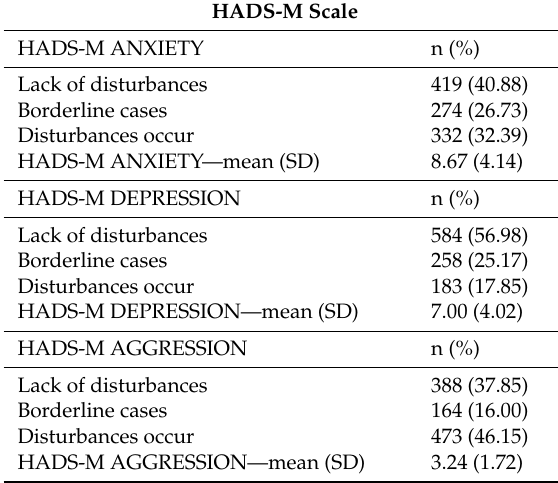
Assessment of anxiety, depression and aggression among the patients examined (HADS-M